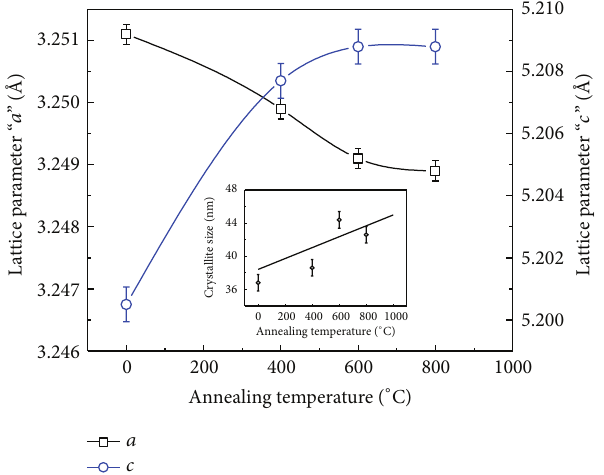
Table 1: EDX quantitative data of as-burnt Zn